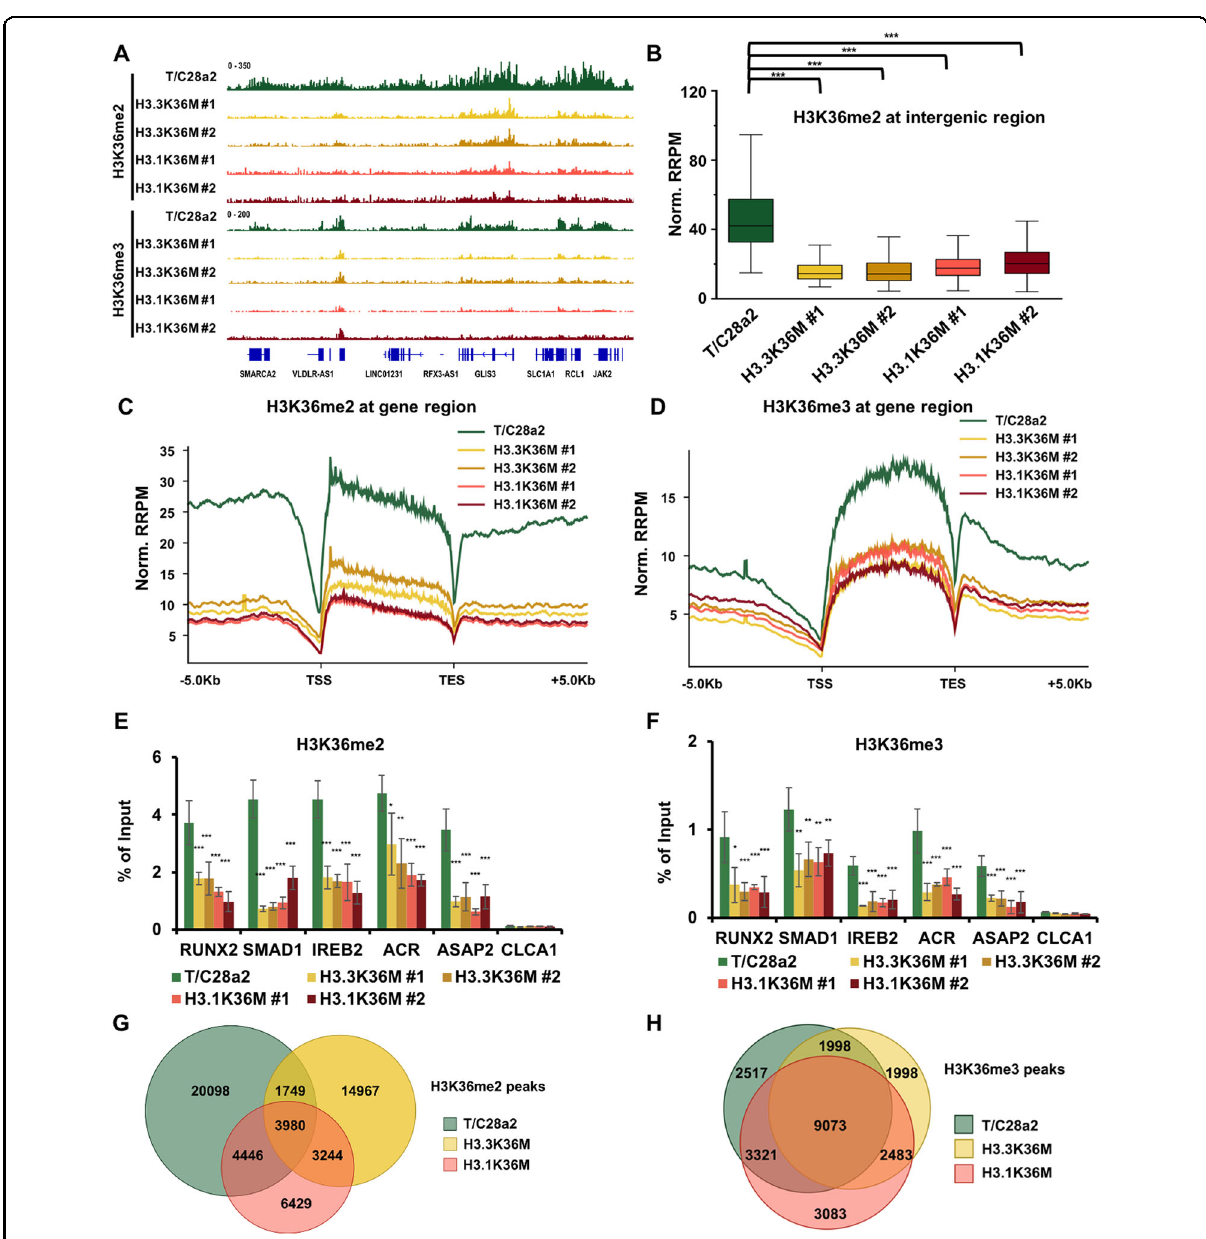
Fig. 3 H3K36 methylation is differentially reprogrammed in H3.3K36M- and H3.1K36M-mutant cells. A Integrative genomics viewer (IGV) tracks representing the distributions of H3K36me2 and H3K36me3 in wild-type (WT), two H3.3K36M-, and two H3.1K36M-mutant cell lines. B , C The normalized read distribution pro fi les of H3K36me2 at intergenic regions ( B ) and gene bodies ( C ) in different cell lines. TSS transcription start sites, TES transcription end sites, Norm. RRPM normalized reference-adjusted reads per million. *** p < 0.001. D The normalized read distribution pro fi les of H3K36me3 at gene bodies in different cell lines. E , F H3K36me2 ( E ) and H3K36me3 ( F ) enrichment were analyzed via ChIP-qPCR in WT and H3K36M- mutant cell lines. The data are represented by the mean ± SD ( N = 3 independent replicates, * p < 0.05, ** p < 0.01, *** p < 0.001). G , H Venn diagram illustrating the overlap of H3K36me2 ( G ) and H3K36me3 ( H ) peaks in WT, H3.3K36M-, and H3.1K36M-mutant cells, respectively. The peaks from independent clones were